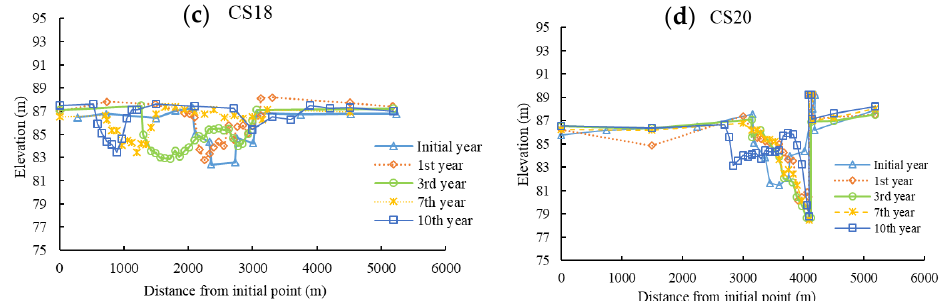
Figure 6. Graphs of different section shapes (nine projects): ( a ) – ( d ) respectively show CS4 section, CS8 section, CS16 section and CS20 section morphological adjustment in different years.